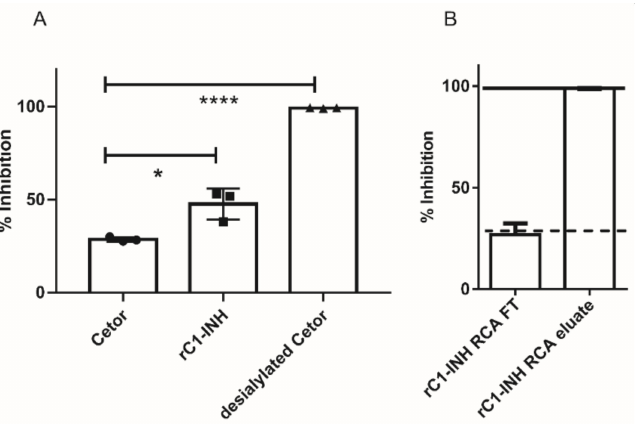
Figure 2. Terminal galactose screening for rC1-INH using RCA 120 . ( A ) Inhibition of desialylated C1- INH to RCA 120 by pdC1-INH, rC1-INH and desialylated C1-INH as positive control. ( B ) Inhibition of desialylated C1-INH to RCA120 by rC1-INH, passed over an RCA120 column to remove terminal galactoses (rC1-INH RCA FT) and with rC1-INH eluted from the RCA120 column (rC1-INH RCA eluate). We can see that the capacity of inhibition by rC1-INH RCA FT is similar to pdC1-INH (dotted line), while the inhibitory capacity of rC1-INH RCA eluate is similar to desialylated C1-INH (solid line). Values are means ± SD of three independent experiments. * p < 0,05; **** p < 0,001 (according to two-tailed Students’